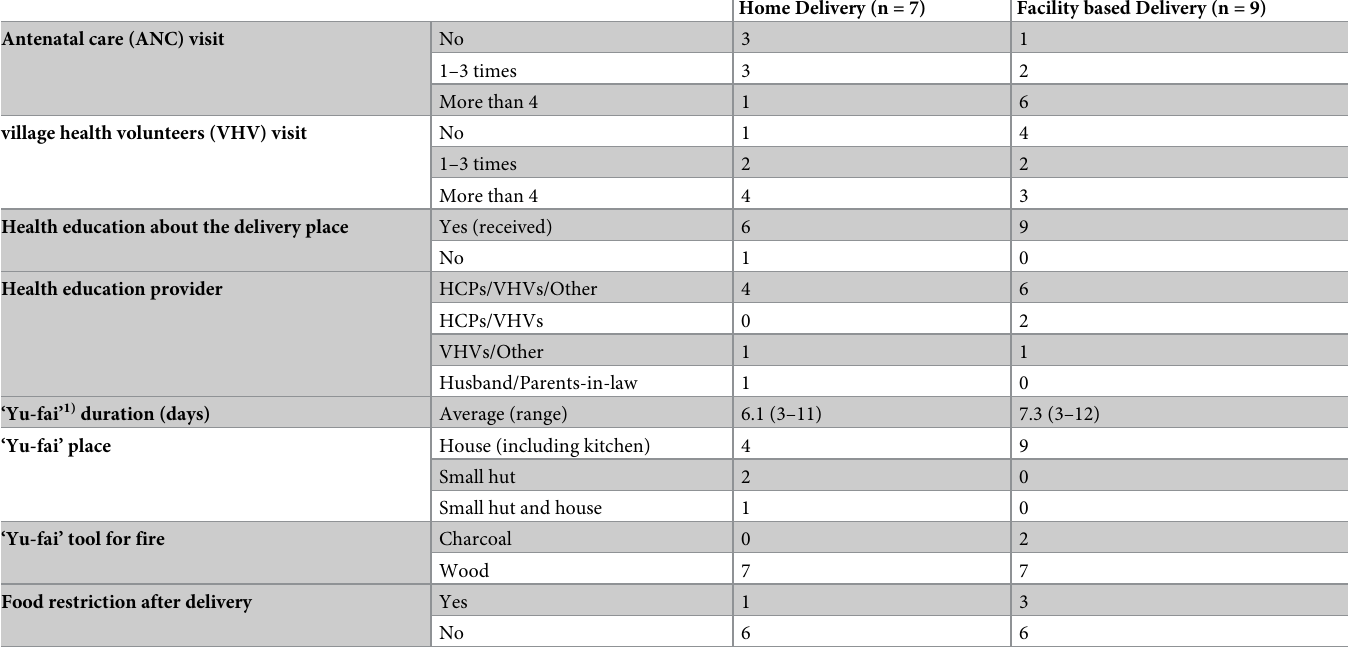
Table 3. Data of our participants related to their latest